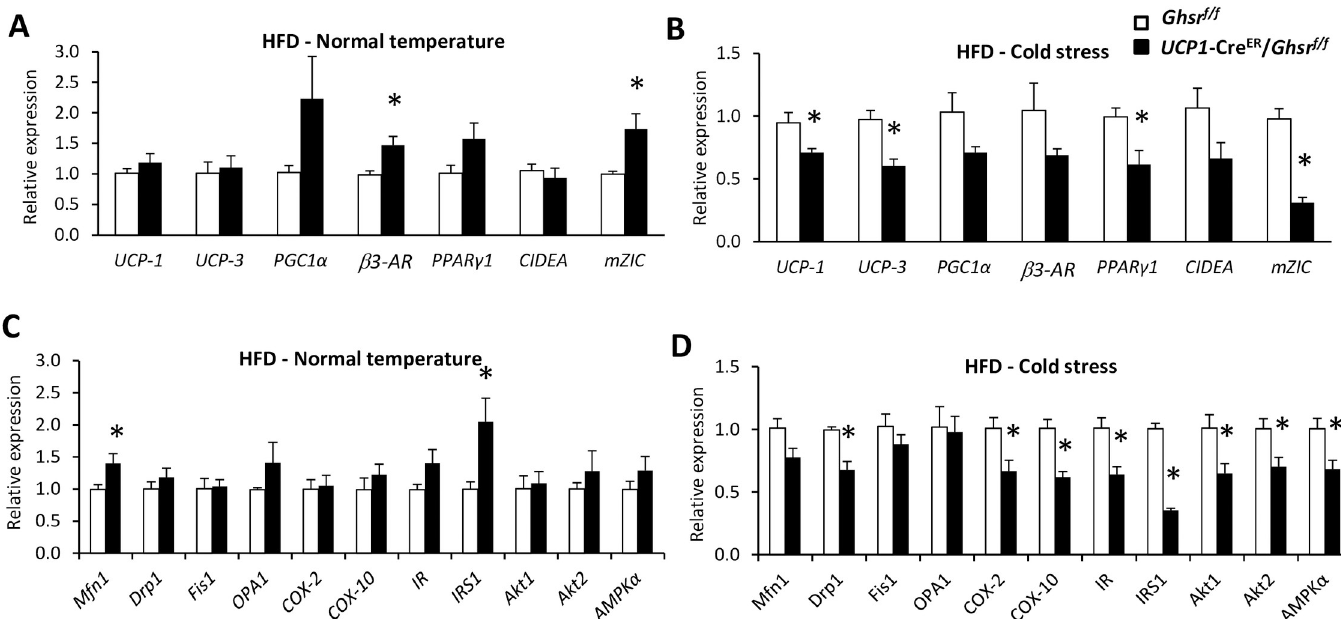
Fig 5. Gene expression profile of BAT in mice fed HFD. BAT from 20-week old male HFD-fed Ghsr f/f and UCP1 -Cre ER / Ghsr f/f mice were either collected under normal housing temperature or after 6 h of 4˚C cold exposure. ( A ) Thermogenic-related gene expression under normal housing temperature. ( B ) Thermogenic-related gene expression under 4˚C cold exposure. ( C ) Expression of mitochondrial and insulin signaling-related genes under normal housing temperature. ( D ) Expression of mitochondrial and insulin signaling-related genes under 4˚C cold exposure. All data were expressed as the mean ± SEM. n = 3–6, � P < 0.05, Ghsr f/f vs . UCP1 -Cre ER / Ghsr f/f .